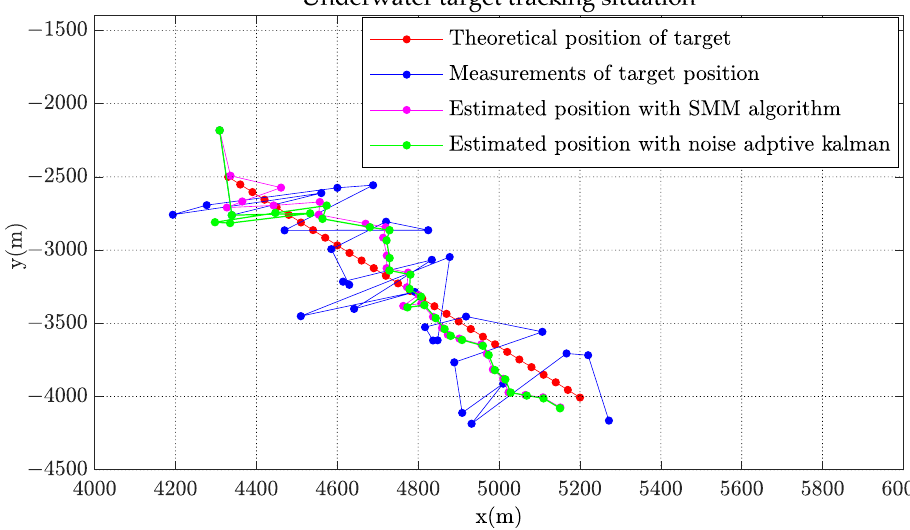
Figure 2. Target and observer position with estimates.